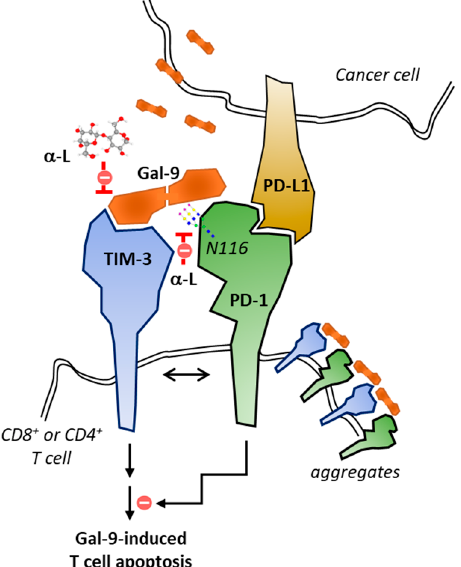
Figure 7. The interplay between PD-1 and TIM-3 and the dual function of Gal-9. Gal-9 is frequently expressed on cancer cells and exists as a soluble protein. Gal-9 has been shown to bind both TIM-3 and PD-1, and to induce apoptosis of CD4 + or CD8 + T cells. However, the co-expression of PD-1 protects TIM-3 + T cells from Gal-9-induced cell death. Gal-9-binding takes place via the N116-linked glycan of PD-1. Gal-9 triggers the formation of TIM-3/PD-1 aggregates. The interaction can be modulated with anti-Gal-9 therapies (adapted from [117]).